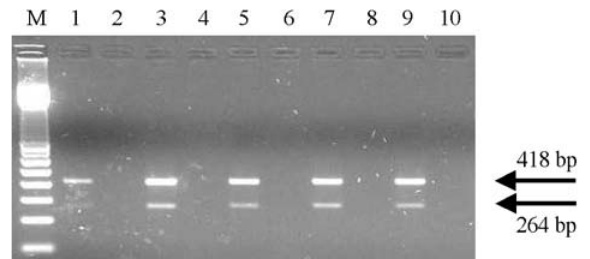
Figure 5 - GH genomic and cDNA amplicons separated by 1.5% agarose gel electrophoresis. Lanes 1-5: Competitive RT-PCR products using 10 ng, 2.5 ng, 0.625 ng, 0.156 ng, and 0.04 ng of 891-bp purified DNA as competitor template, obtained from genomic DNA, and 75 ng of total RNA. The 418-bp band represents the GH cDNA. The heteroduplex is showed between the 891-bp and 418-bp